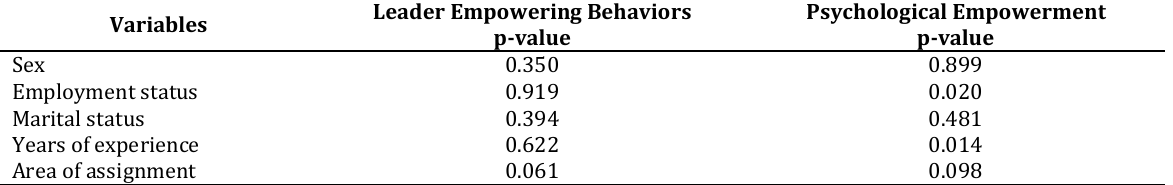
Table 3. Differences in leader empowering behaviors and psychological